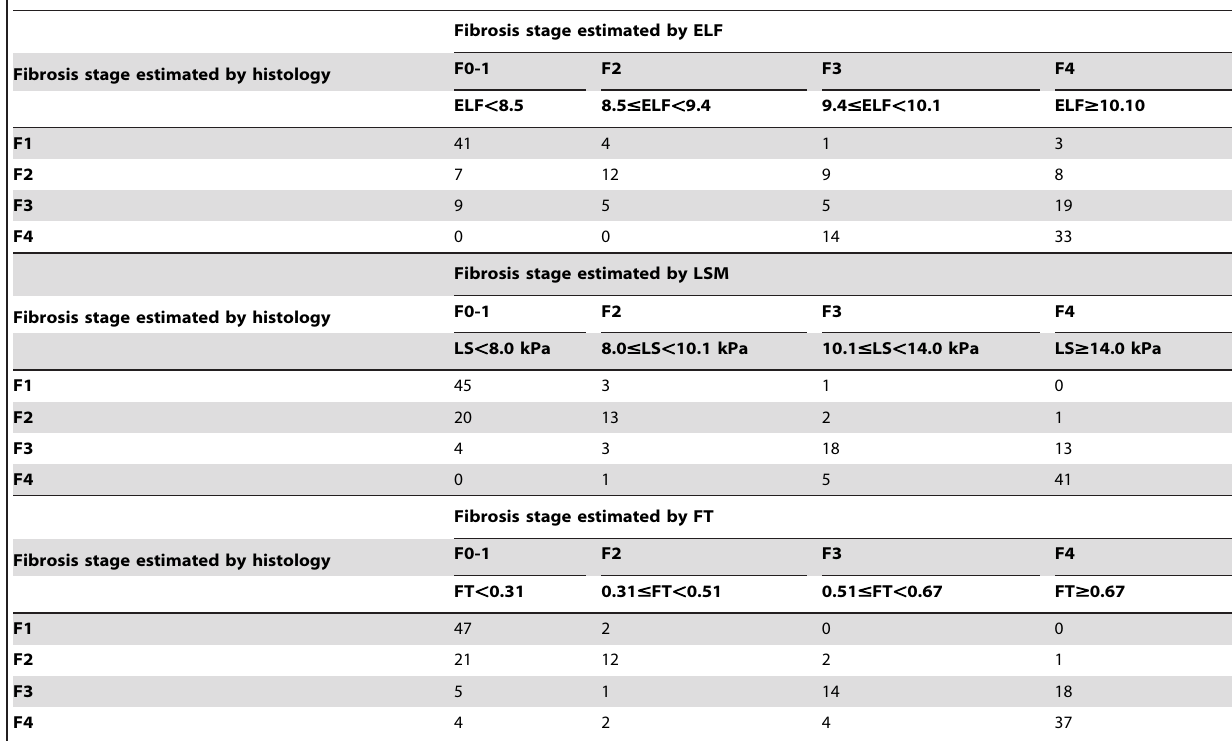
Table 3. Distribution and agreement of fibrosis stages according to histology and ELF, LSM or FT (n=170).